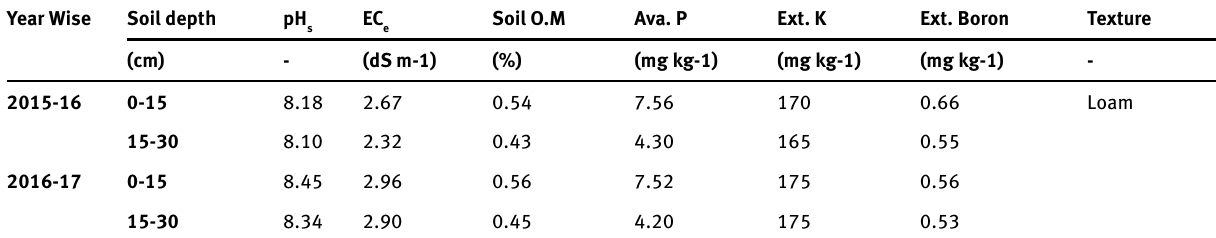
Figure 1. Meteorological data of 2016 and 2017 Table 1. Characteristics of experimental soil before treatments